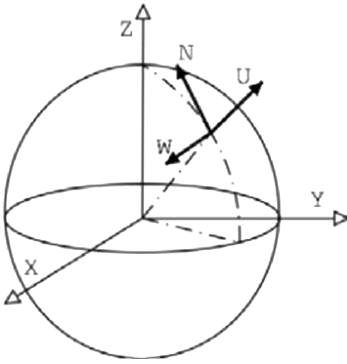
Figure 2. INS coordinate system.